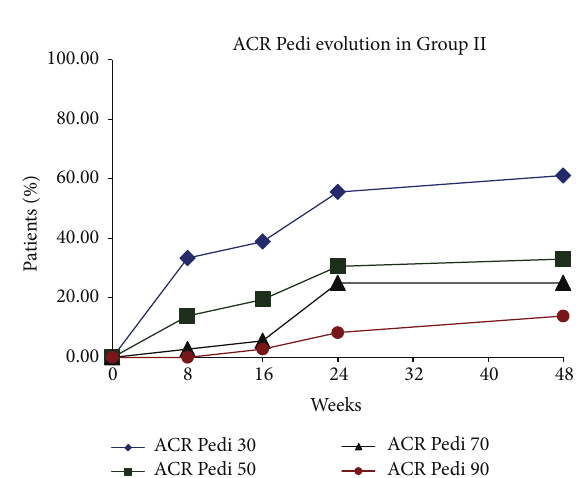
Figure 5: Evolution of ACR Pedi 30/50/70/90 responses in placebo group.